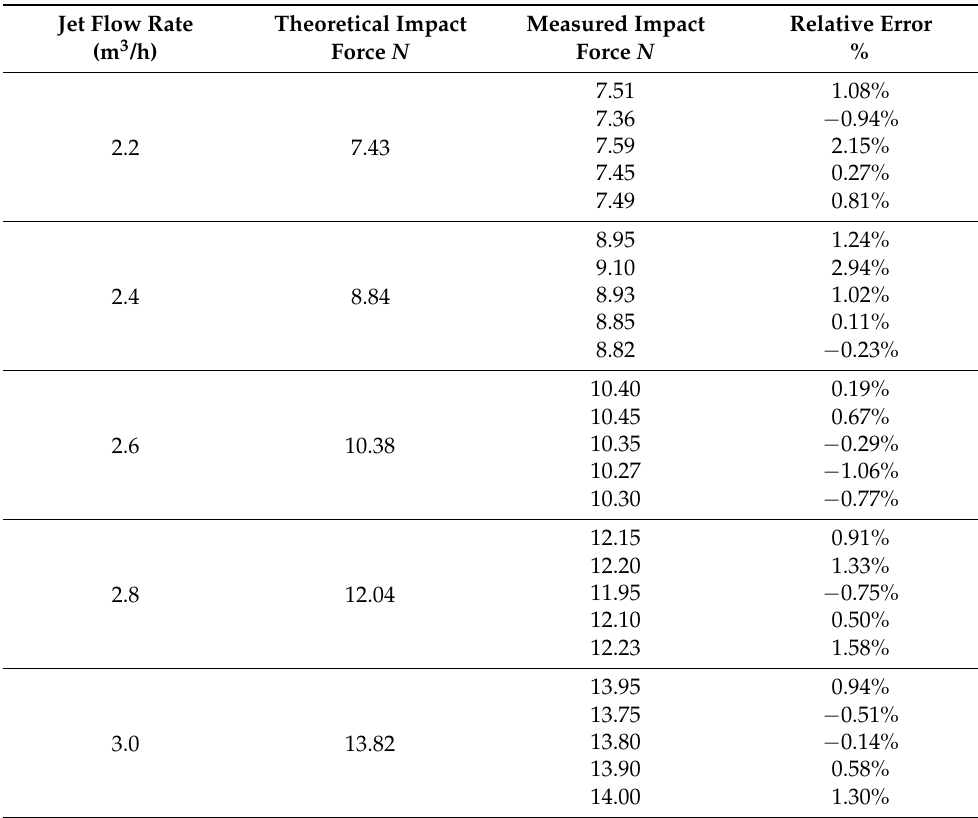
Table 5. Experiment